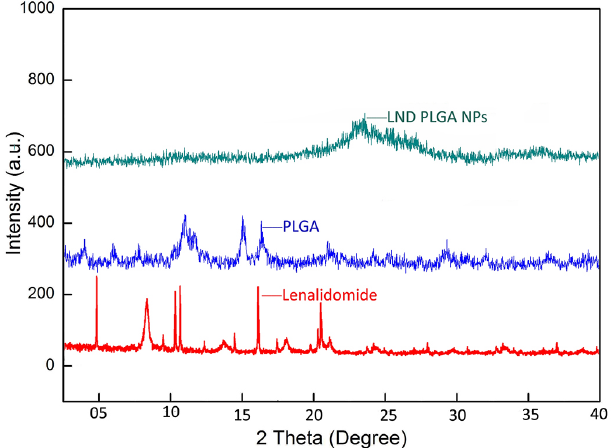
FIGURE 6 - XRD of lenalidomide, PLGA and lenalidomide-